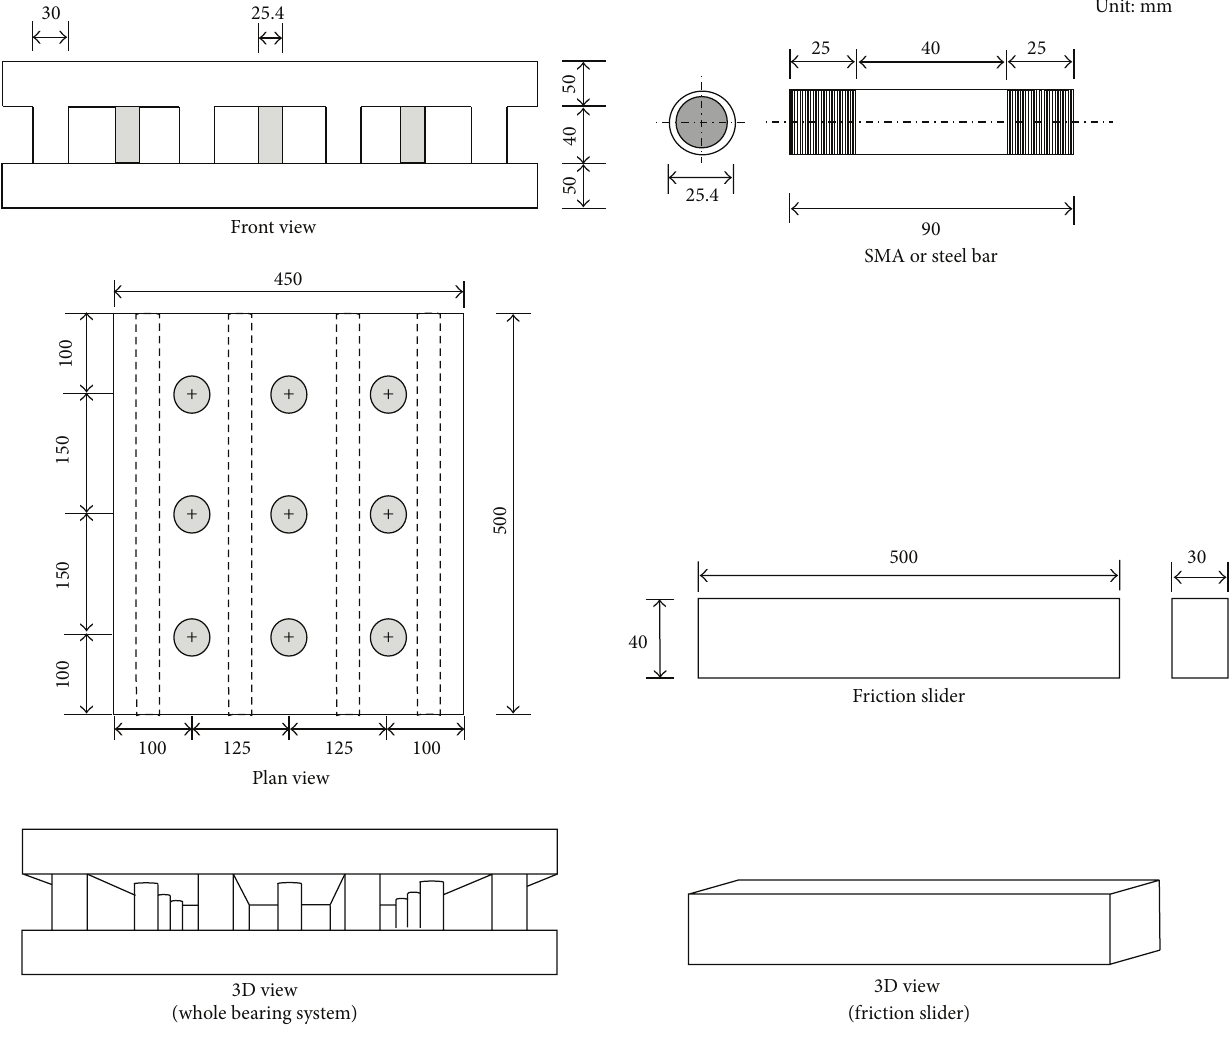
Figure 4: Design of the recentering bridge bearing combined with the friction slider